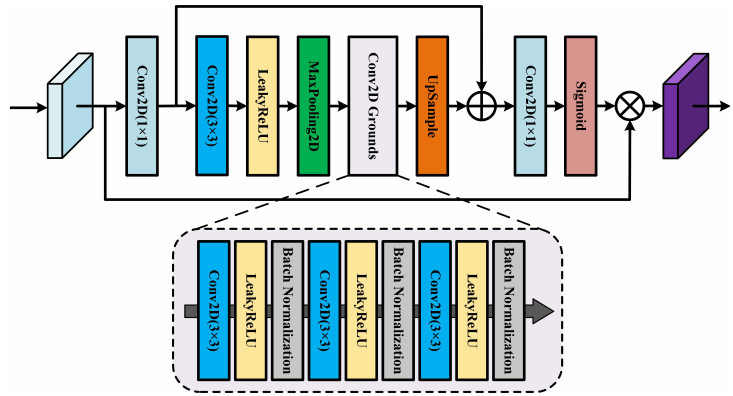
Figure 4. Enhanced spatial attention